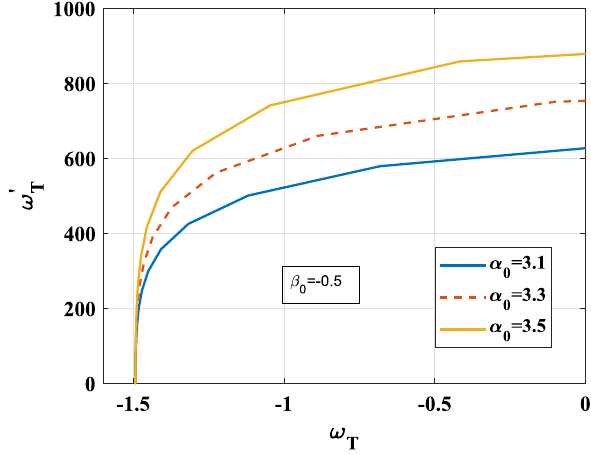
Fig. 11 Plot of ω T versus ω (cid:2) γ = 101, and β = − 0 . 3 1